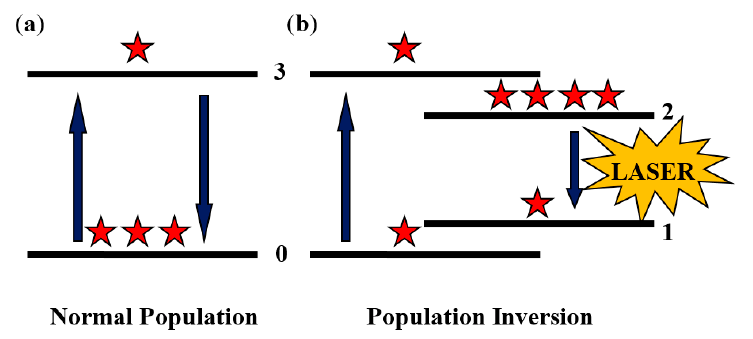
Figure 5. Schematic illustration of the normal population ( a ) and population inversion ( b ). Upward arrows show optical pumping which make electrons (solid stars) to rise from a lower energy level 0 to a higher one 3. Downward arrows indicate electrons emit photons when they relax from excited states 3 or 2 to lower states 1 or 0. Table 1. The lattice constants of optimized atomic structures of ZnTe and TM 2 + 0.25 Zn 0.75 Te ( TM = V, Cr, Mn) fit other theoretical values. The corresponding band gaps are compared with other calculated values. Compounds Lattice Constant (Å) Energy Gap